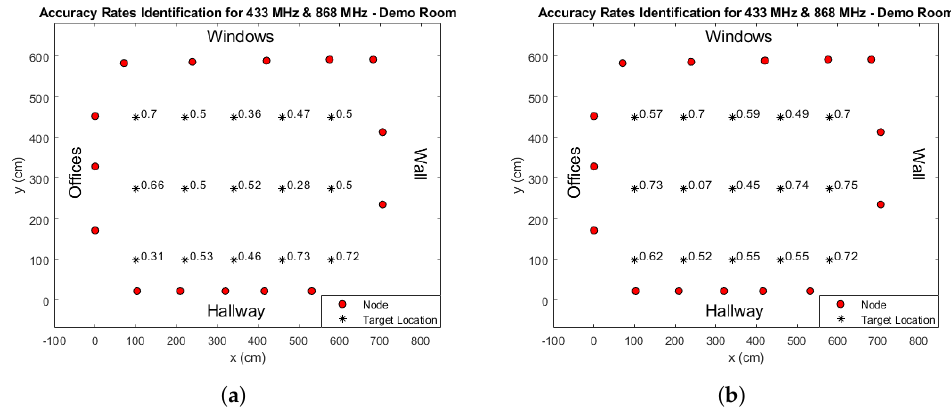
Figure 12. Identification accuracy rates for each location for both the ( a ) Euclidean distance minimization and ( b ) naive Bayesian classifier approach applied to 433 MHz and 868 MHz RSS data.